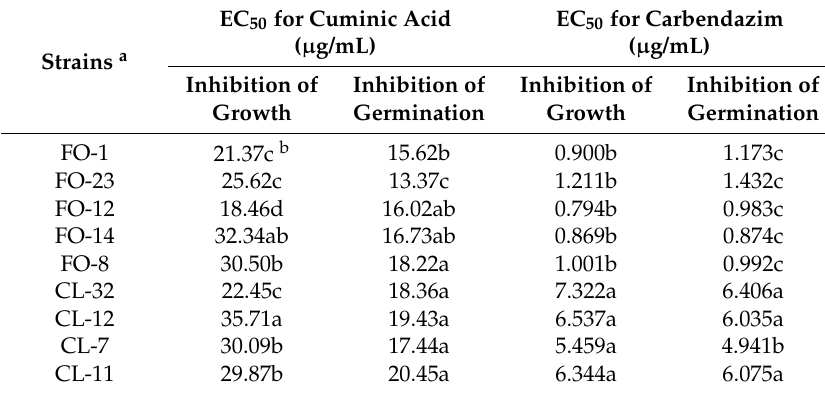
Table 1. Sensitivity to cuminic acid and